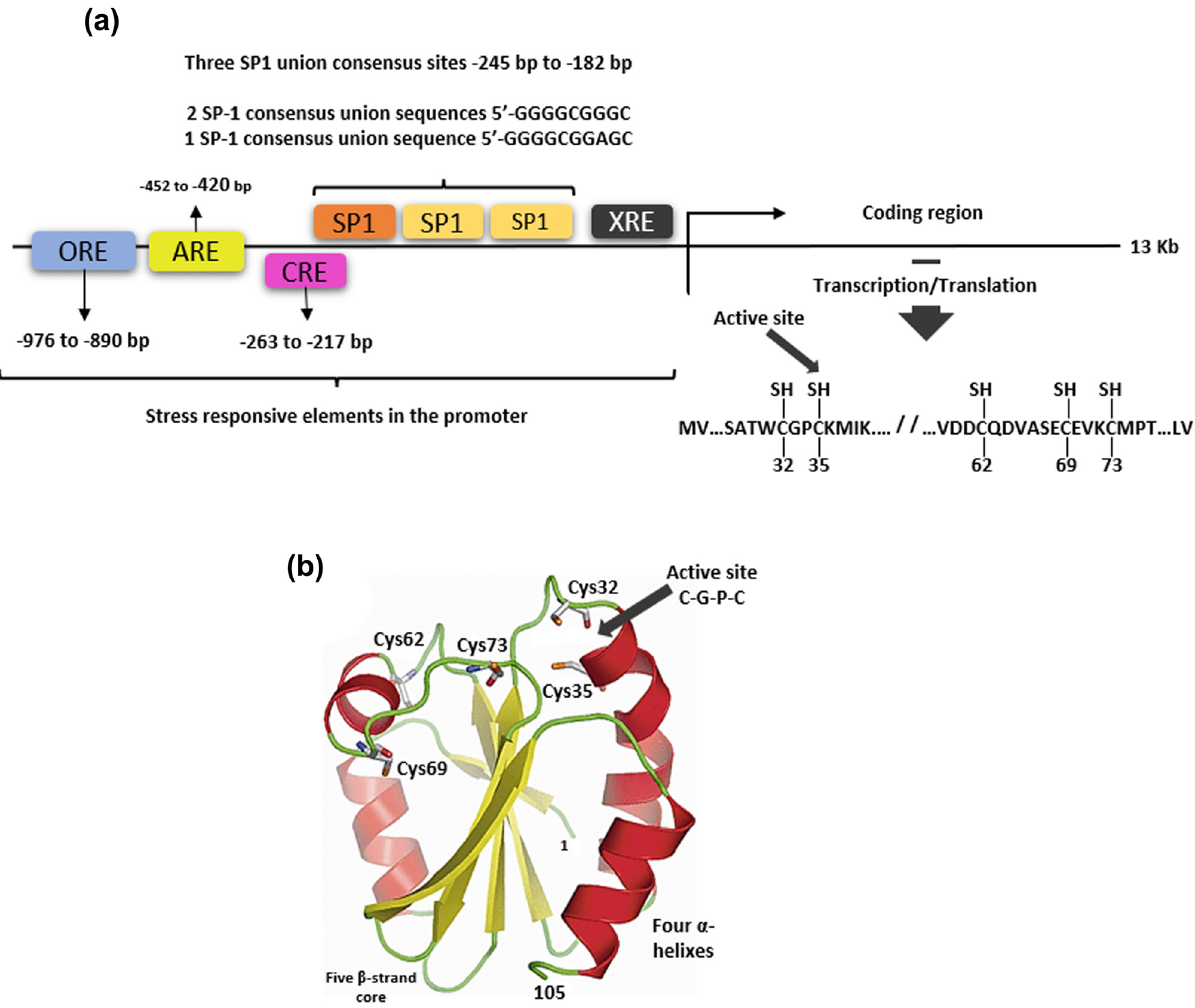
Figure 1: Human TRX1. ( a ) Gene structure showing the stress response elements in the promoter: ORE, ARE, CRE, XRE, SP1, and coding sequences where the important cysteines are located. ( b ) Model showing the typical structure of TRX1 with four helixes surrounded by fi ve β - laminae, cysteines of the active redox site ( Cys32 and Cys35 ) and cysteines that participate in transnitrosylation ( Cys62, Cys69, and Cys73 ) . PDB code: